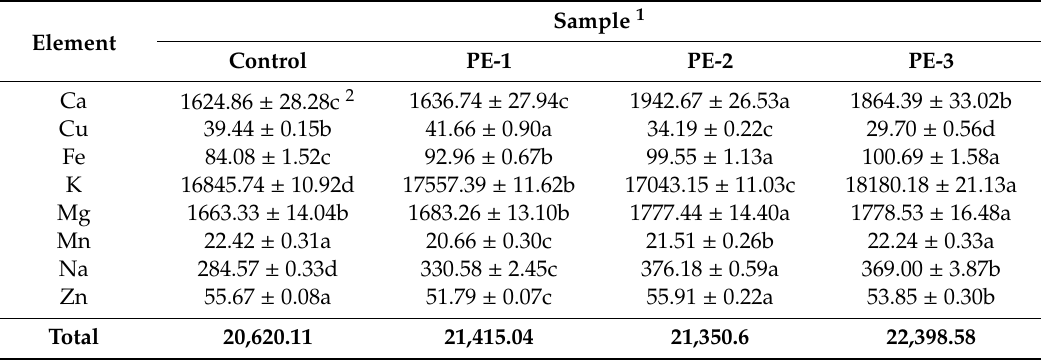
Table 4. Mineral contents (mg / kg of dry weight) of soybean sprouts grown after seed-soaking in di ff erent concentrations of Pu-erh tea extracts.